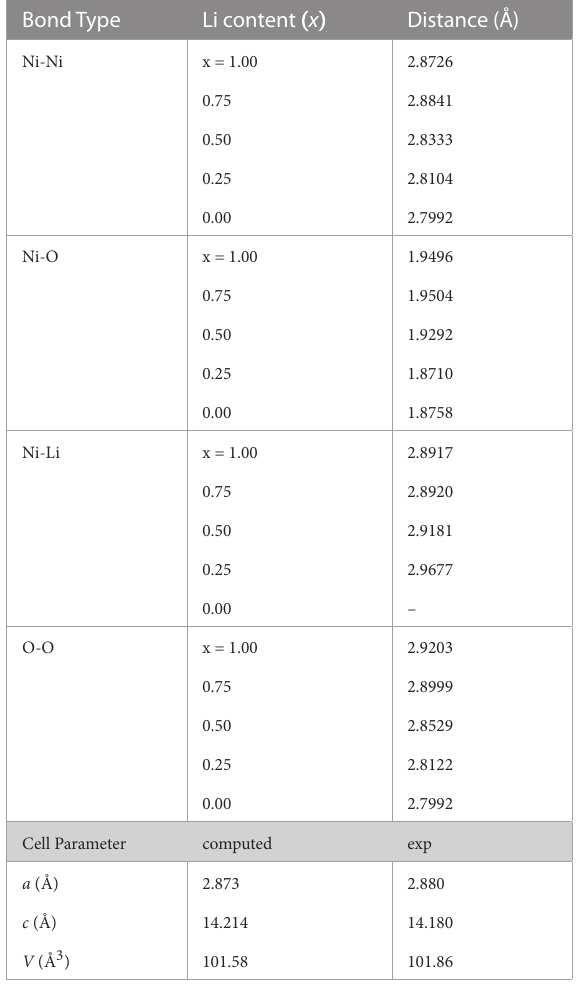
TABLE4 ThebandGapofLCOcomputedwithdifferentmethodsand U parameters(computedandrescaled).ThevaluesareprovidedineV. Value of Hubbard